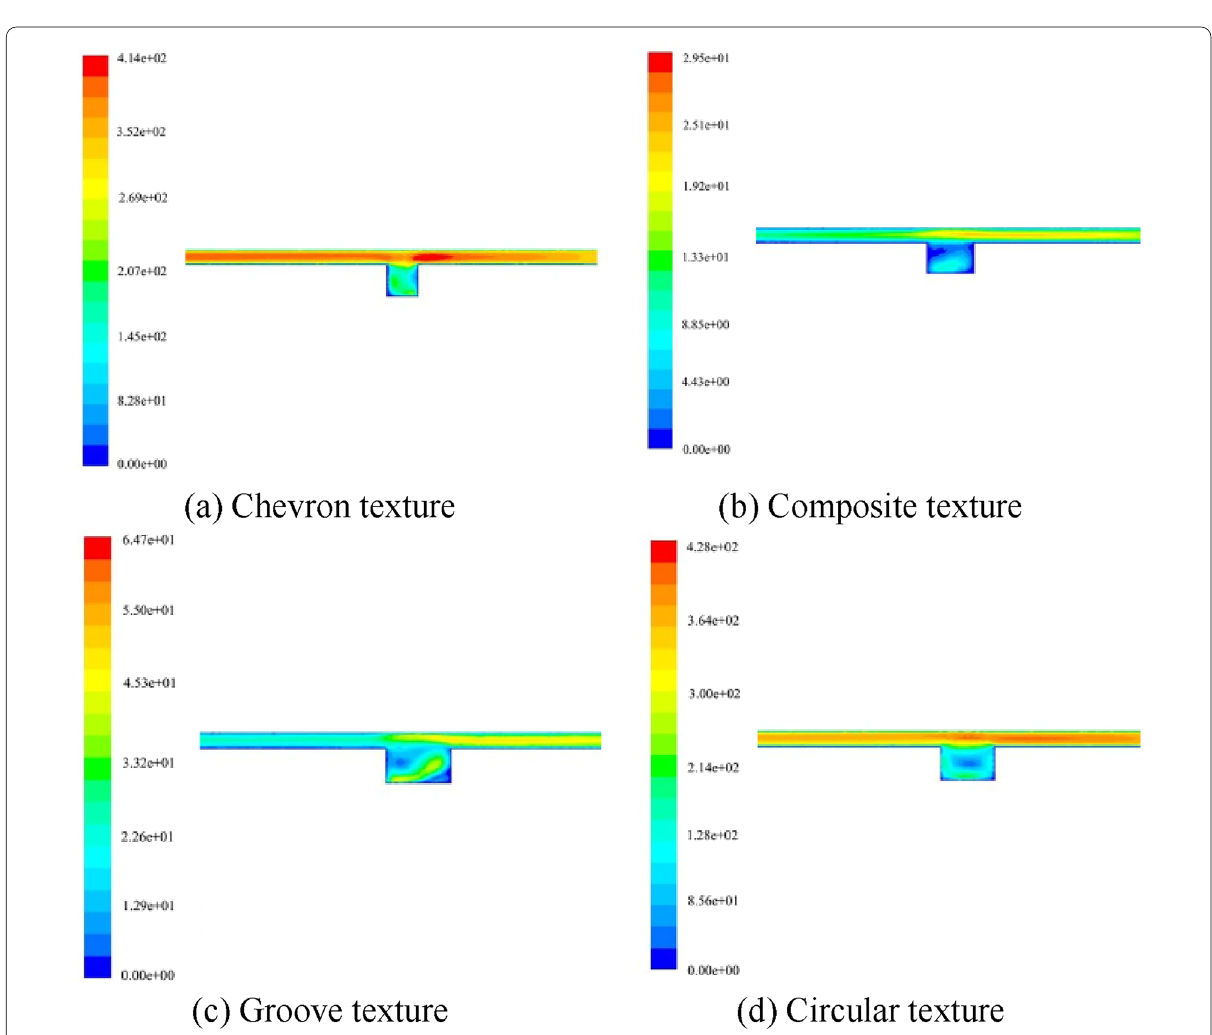
Figure 5 Cloud diagram of velocity distribution (mm/s)